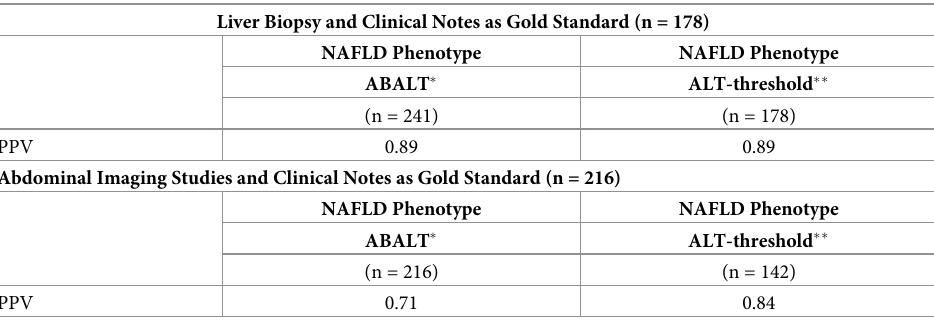
Table 4. Electronic health record validation of NAFLD